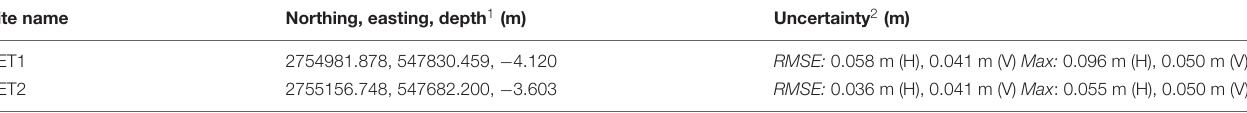
TABLE 1 | Coordinates of the Crocker Reef Surface Elevation Table (SET) stations as measured by a survey-grade Global Navigation Satellite System